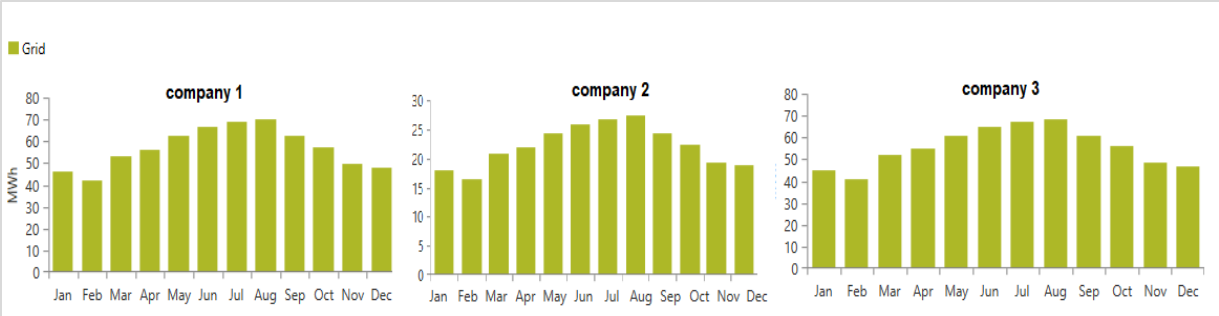
Figure 9. Monthly electric load for the three companies (Fez region), 2021.